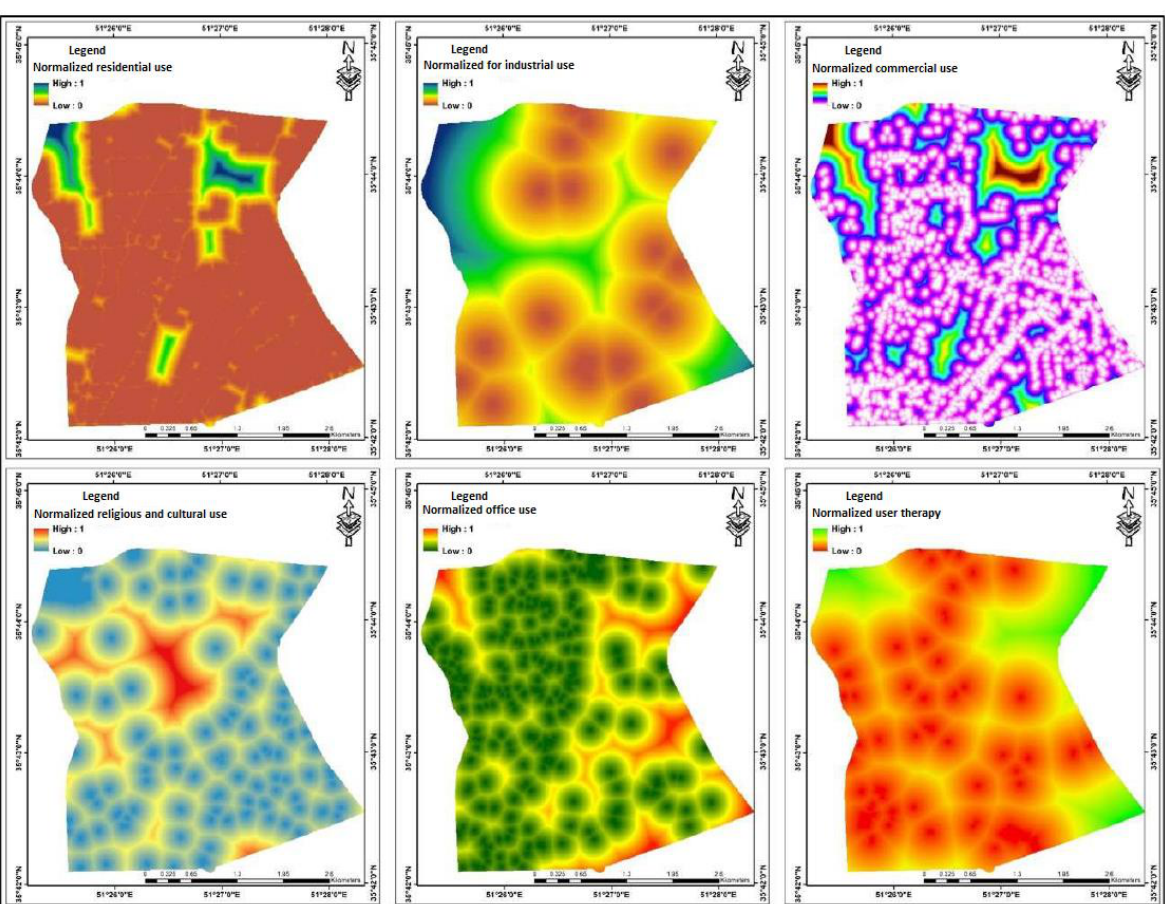
Figure 10. Fuzzy distance from incompatible